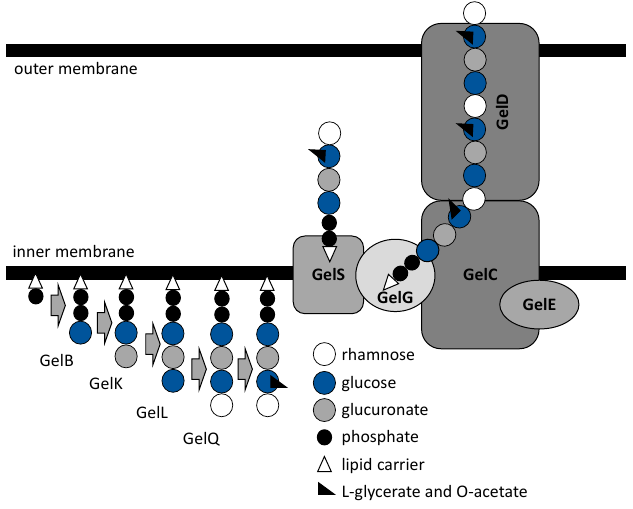
Figure 1. Schematic model of xanthan polysaccharide biosynthesis machinery.